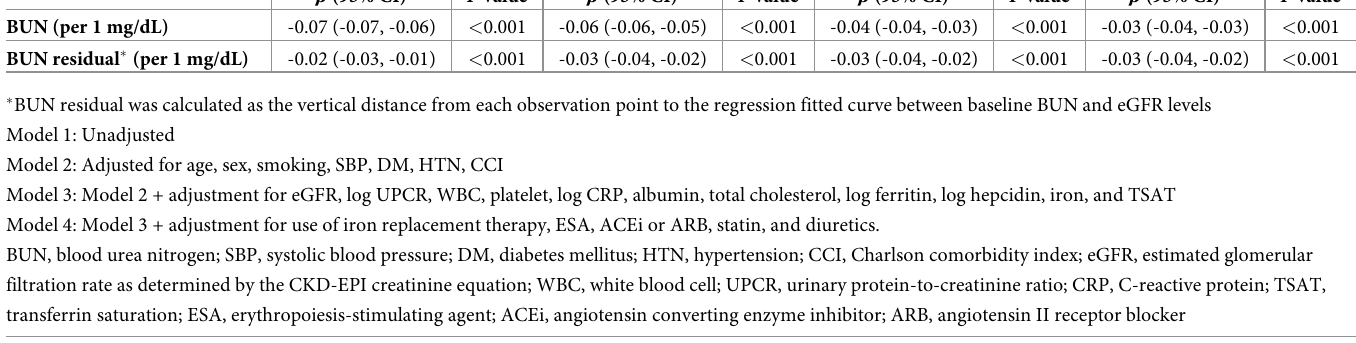
Table 2. Multivariable linear regression analyses of the association between BUN, BUN residual, and hemoglobin level.